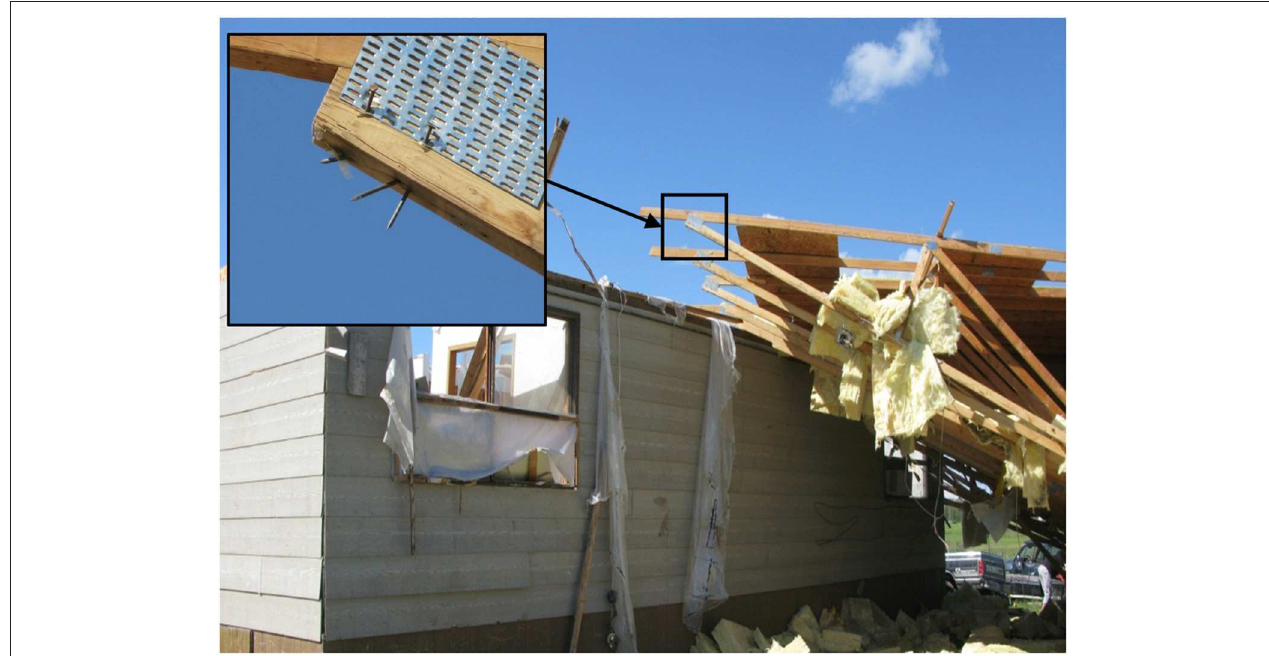
FIGURE 5 | Failure of toe-nailed roof-to-wall connection from an F3 tornado that hit Raymore, SK in June